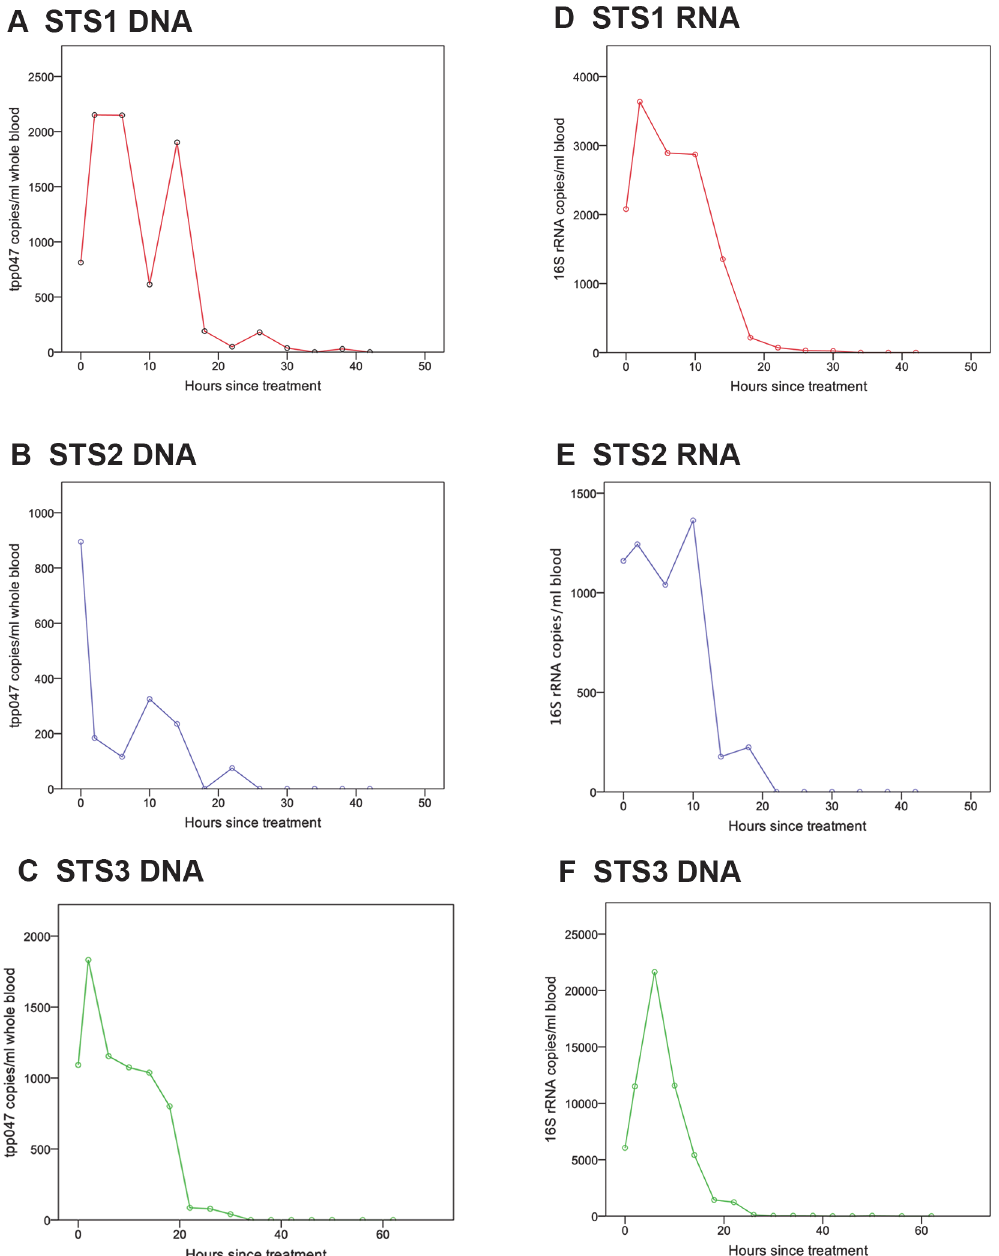
Fig 1. Three patients with microbiologically confirmed early syphilis were treated with a 2.4 megaunit dose of benzathine penicillin at time zero. Panels A to C represent DNA clearance for three patients and Panels D to F depict RNA clearance for the same patients. Error bars represent 95% confidence